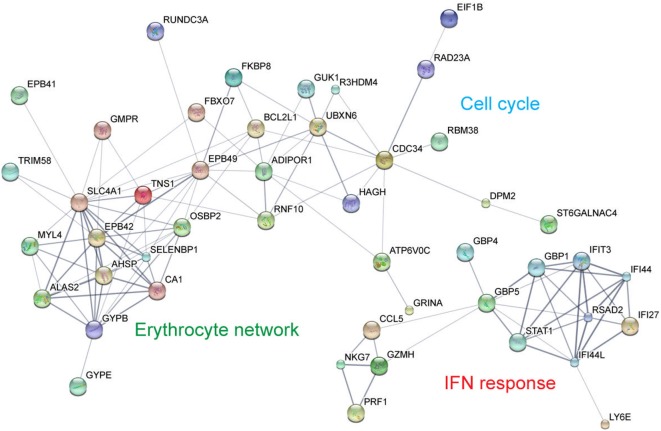
Differentially expressed genes upon congenital neonatal human cytomegalovirus (HCMV) infection form distinct subnetworks. STRING Network analysis was performed on the 114 genes with the highest significant differential expression (absolute log2FC ≥ 1.58, adjusted p < 0.05) upon congenital neonatal HCMV infection (Inf-075). Network analysis reveals the presence of two interconnected subnetworks comprising erythrocyte-specific genes (erythrocyte network), cell metabolic genes, and cell-cycle genes (cell cycle), as well as a distinct and separate subnetwork of IFN-induced genes with antiviral activity (IFN response).